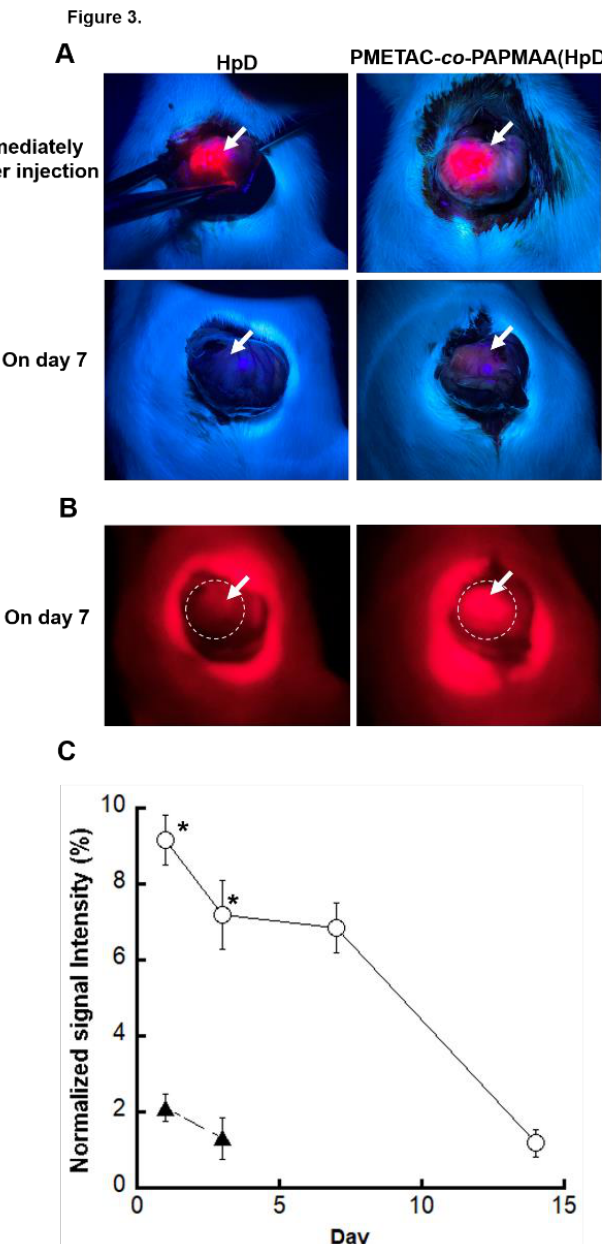
Figure 4. Fluorescent detection of HpD and PMETAC- co -PAMPAA(HpD) on the exposed stomach after their local injection into the anterior wall of the stomach of rats. ( A ) Photo of the exposed stomach under the irradiation at 375 nm by LED light immediately (upper images) and on day 7 (lower images) after their local injection. White arrows indicate the injection site. ( B ) Photo of the exposed stomach under the irradiation at 375 nm by LED light on day 7 after their local injection, which was captured by digital camera equipped with a red gelatin filter. The fluorescent signals of HpD and aHpD were indicated in the white dotted circle. White arrows indicate the injected site. ( C ) Time course of fluorescent intensity of HpD (closed triangle) and PMETAC- co -PAMPAA(HpD) (open circle) on the anterior wall of the extracted stomach. Data are shown as mean ± SEM ( n = 3). * p < 0.05, compared with the HpD